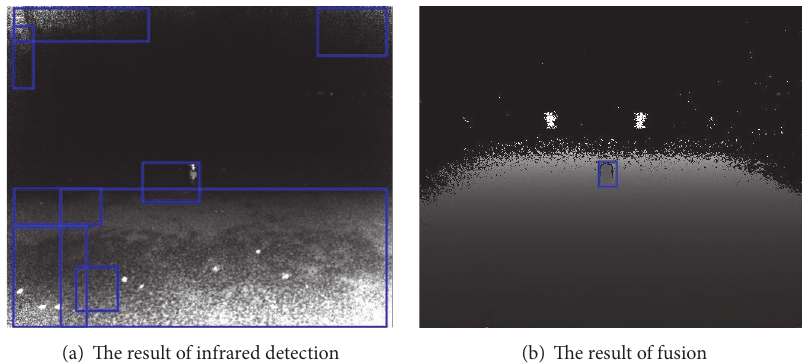
Figure 3: An example of single obstacle.